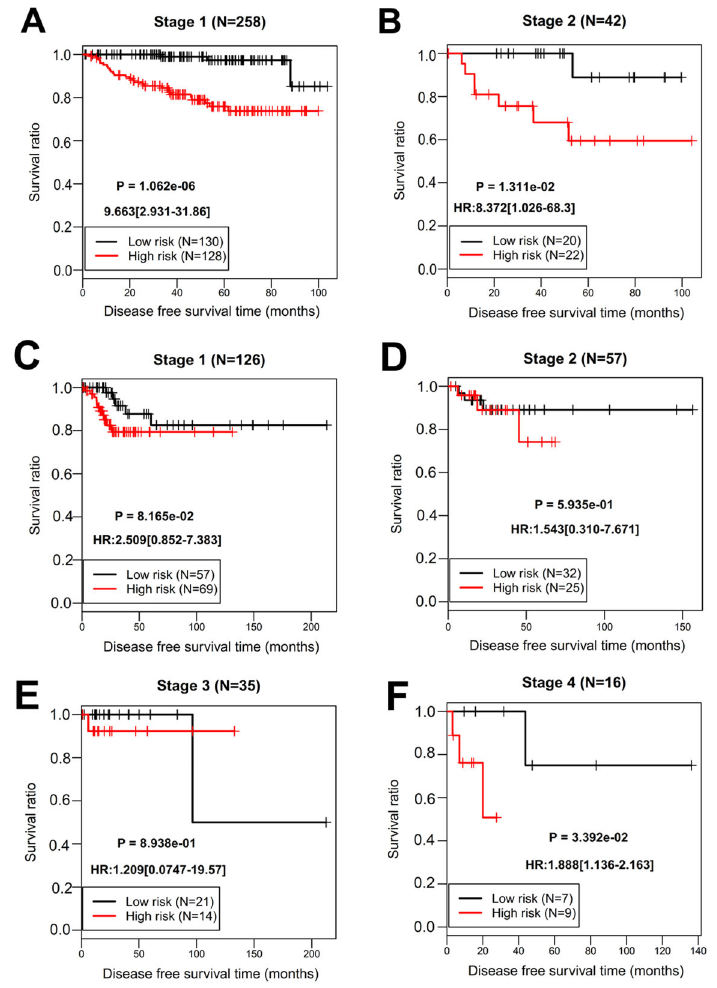
Figure 5. Strati fi cation analysis according to the FIGO staging. Kaplan-Meier survival curve for A , patients with stage 1 (GSE44001); B , patients with stage 2 (GSE44001); C , patients with stage 1 (TCGA); D , patients with stage 2 (TCGA); E , patients with stage 3 (TCGA); F , patients with stage 4 (TCGA). HR: hazard